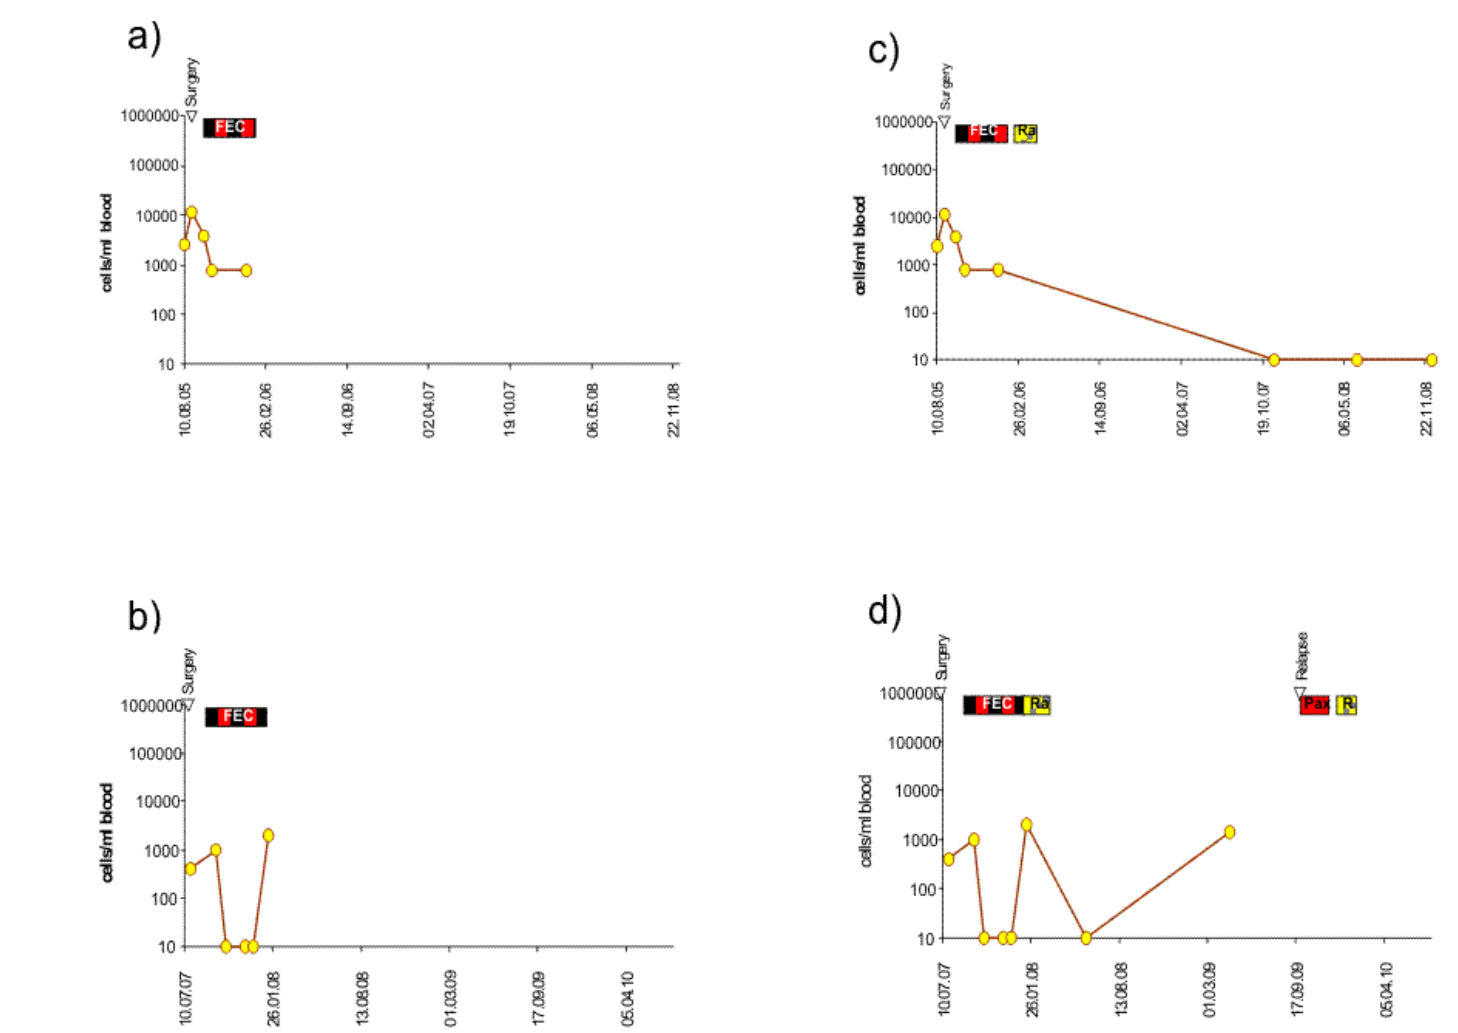
Figure 4. Typical courses of the behavior of vital cells during treatment in (a) and (b) an individual patient with triple negative tumor in complete remission and (c) and (d) with relapse. Treatment bars: as above. Pa: